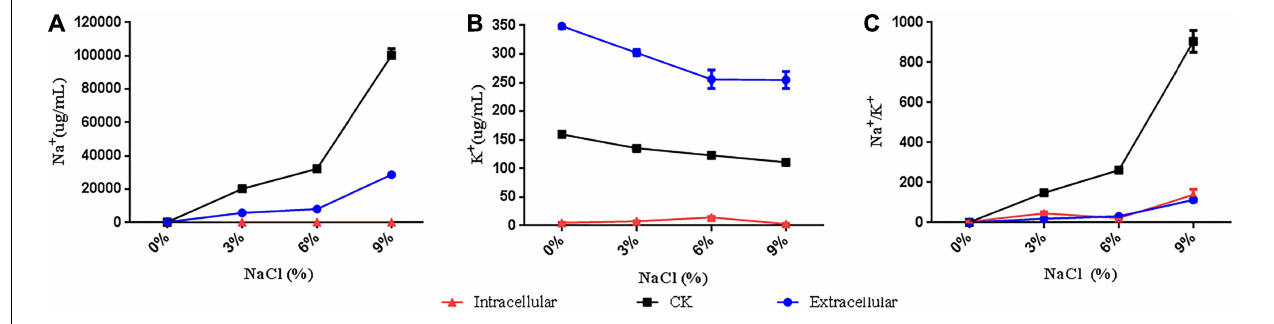
FIGURE 5 | Na + and K + concentrations of R. aquatilis JZ-GX1 in the presence of different salt concentrations. (A) Na + content. (B) K + content. (C) Na + /K + .